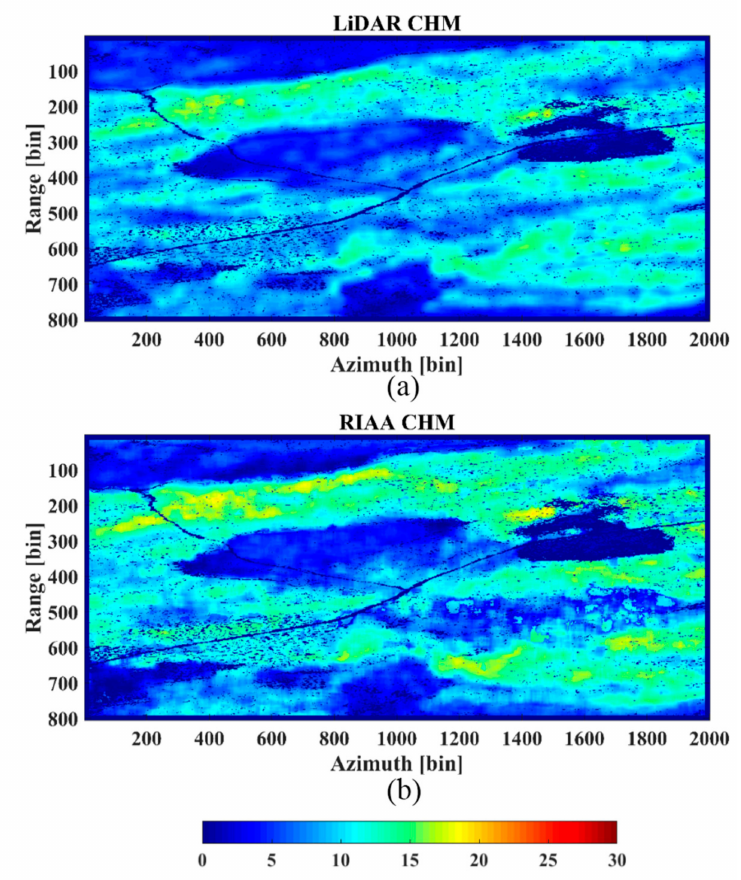
Figure 9. ( a ) The LiDAR CHM. ( b ) The forest height estimated by the RIAA TomoSAR method.